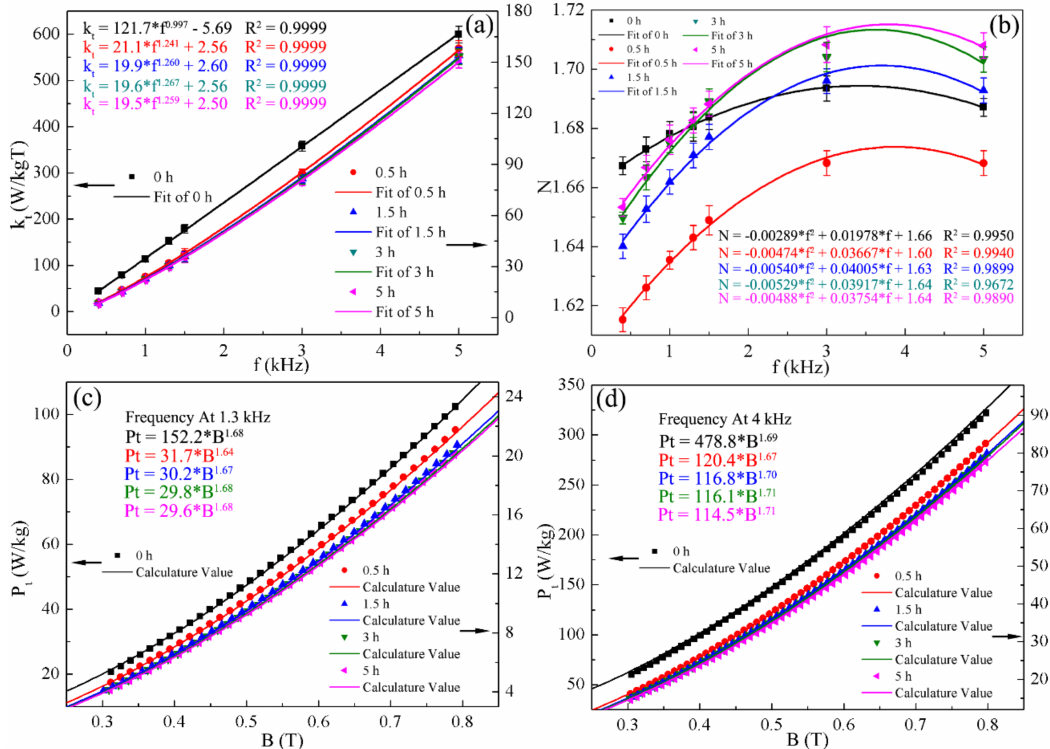
Figure 4. ( a ) AC iron loss coefficient k t and fit results; ( b ) AC iron loss factor N and fit results. The iron loss test result and calculation value at ( c ) 1.3 kHz frequency and ( d ) 4 kHz frequency. ( a , c , d ) have two y axes: the left vertical axe represents results before heat treatment and the right vertical axe represents results after heat treatment with different